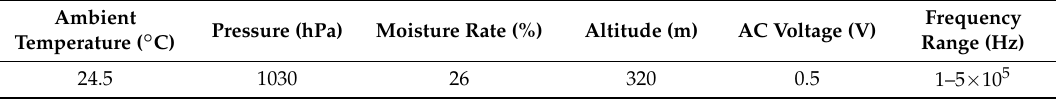
Table 3. Details of the impedance spectroscopy measurement.